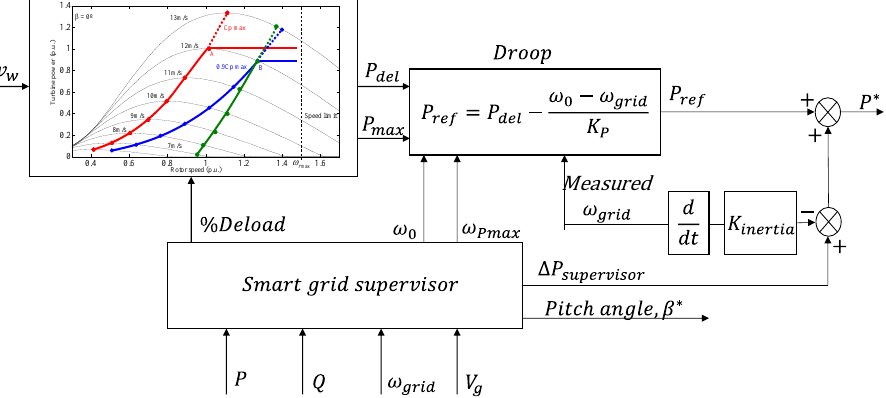
Figure 8. DFIG reference generation of active power. Droop and smart grid supervisor defined con- trol.